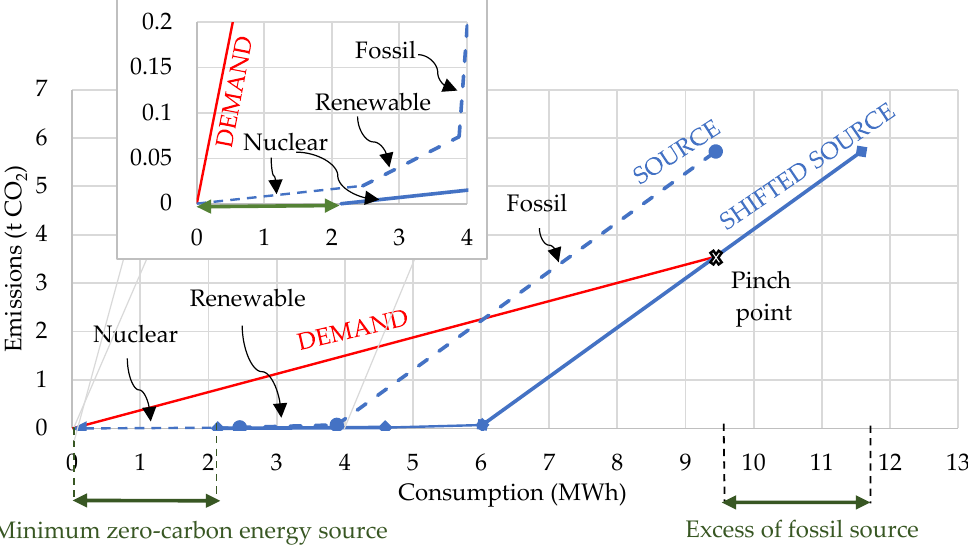
Figure 2. Pinch diagram for 1 t of aluminum slugs with a minimum zero-carbon source.